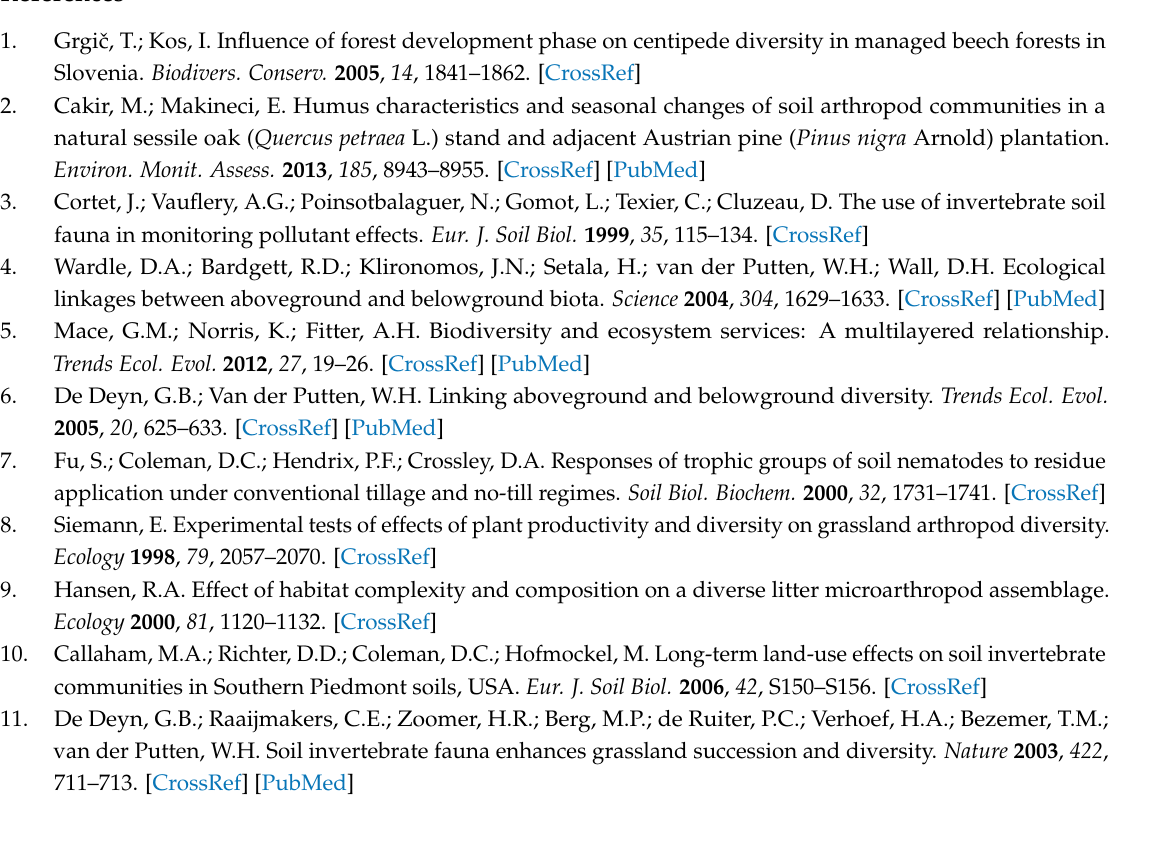
Figure S1: Total precipitation (mm) and mean temperature ( ◦ C) three months prior to sampling dates in the study area, during 2013–2014. The data are from the local meteorological station, Table S1: The effects of stand age (A) and sampling date (D) on the abundance of total groups and major